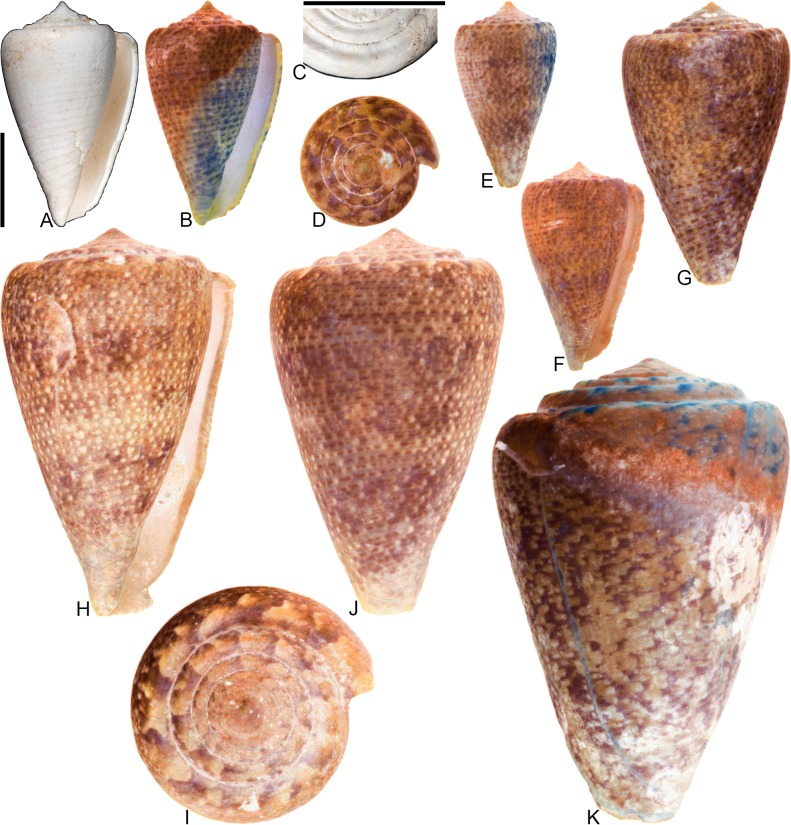

Conus (Spuriconus?) kaesleri Hendricks sp. nov.All specimens are from locality station TU 1354 (Gurabo Fm.). (A-D) PRI 66185 (holotype), SL 22.6 mm; (E) PRI 67668 (paratype), SL 18.8 mm; (F) PRI 67669 (paratype), SL 21.2 mm; (G) PRI 67667 (paratype), SL 28.5 mm; (H-J) PRI 67666 (paratype), SL 38.7 mm; (K) PRI 67670 (paratype), SL 46.5 mm. (B, D-K) are reversed images of specimens photographed under UV light. Scale bar to the left of (A) is 1 cm and pertains to (A-B, D-K); (C) scale bar is 1 cm.